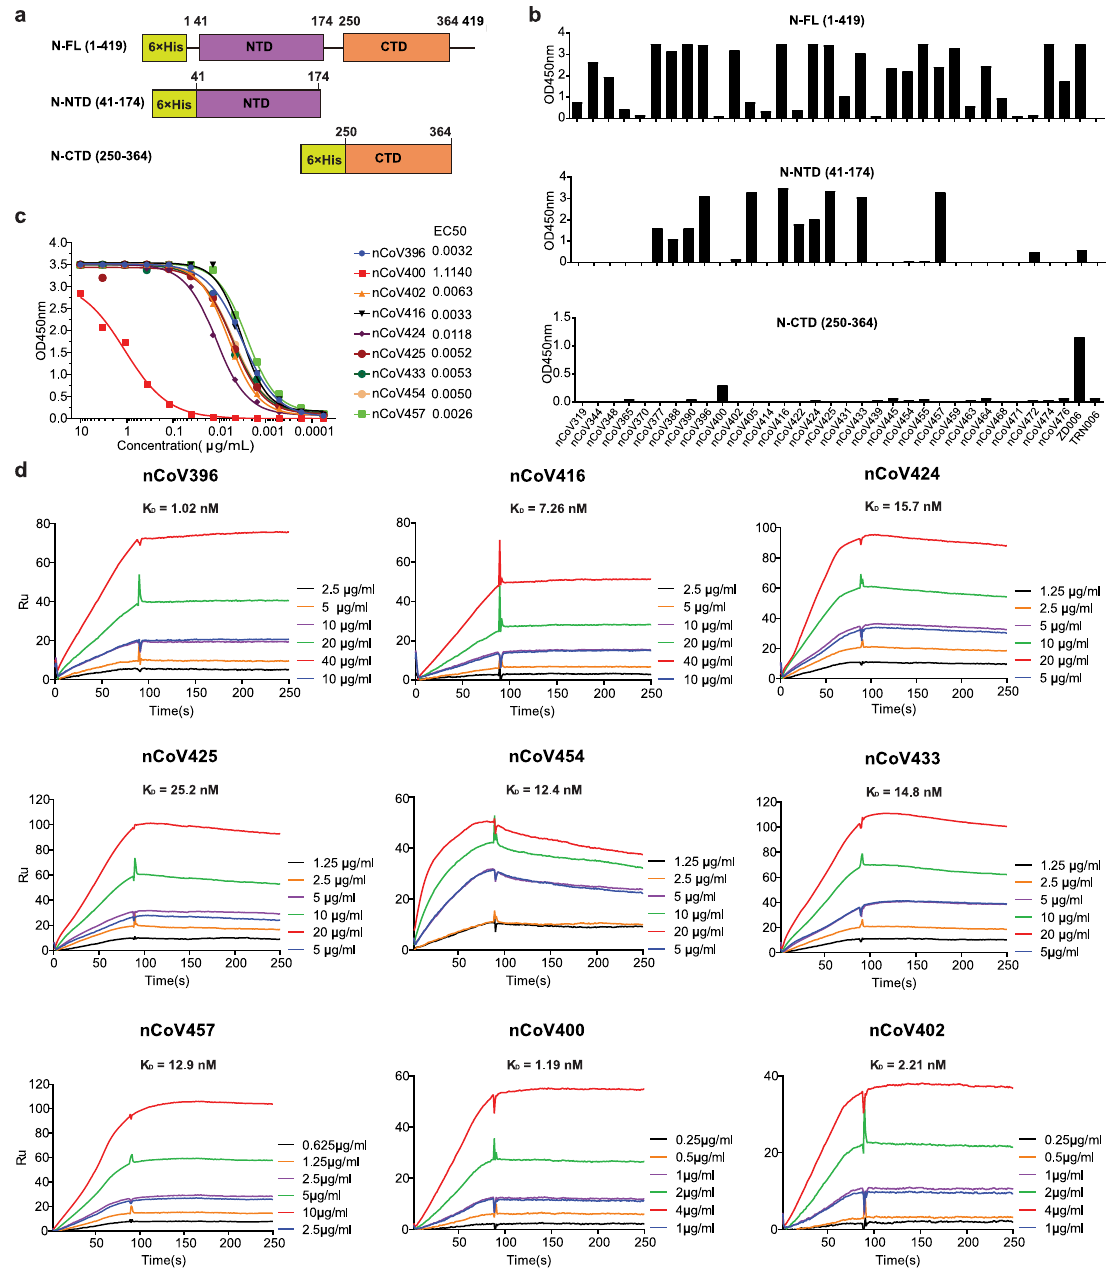
Fig. 2 Reactivity and af fi nity of the isolated antibodies to the N protein antigens. a Schematic presentation of the SARS-CoV2 N protein and two variants. b Antibodies expressed in transfected 293 cells were evaluated for binding to N-FL, N-NTD and N-CTD by ELISA. Plasma from the patient ZD006 and an irrelevant mAb TRN006 were used as positive control and negative control, respectively. c The ability of nine puri fi ed antibodies to the N-FL protein was determined by ELISA. d Binding af fi nity of nine selected antibodies to N protein were measured by SPR. KD values are shown above the individual